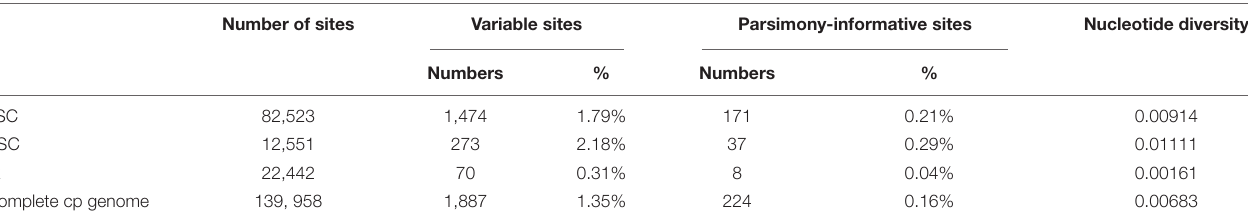
FIGURE 2 | Comparison of chloroplast genomes of four Pennisetum species and other three Paniceae species ( P. geminatum , S. secundatum , and S. talica ) with P. glaucum as the reference using mVISTA program. The top line shows the genes in order. A cut-off of 70% identity was used for the plots and the Y -scale represents the percent identity between 50 and 100%. TABLE 3 | Variable sites analyses in Pennisetum chloroplast